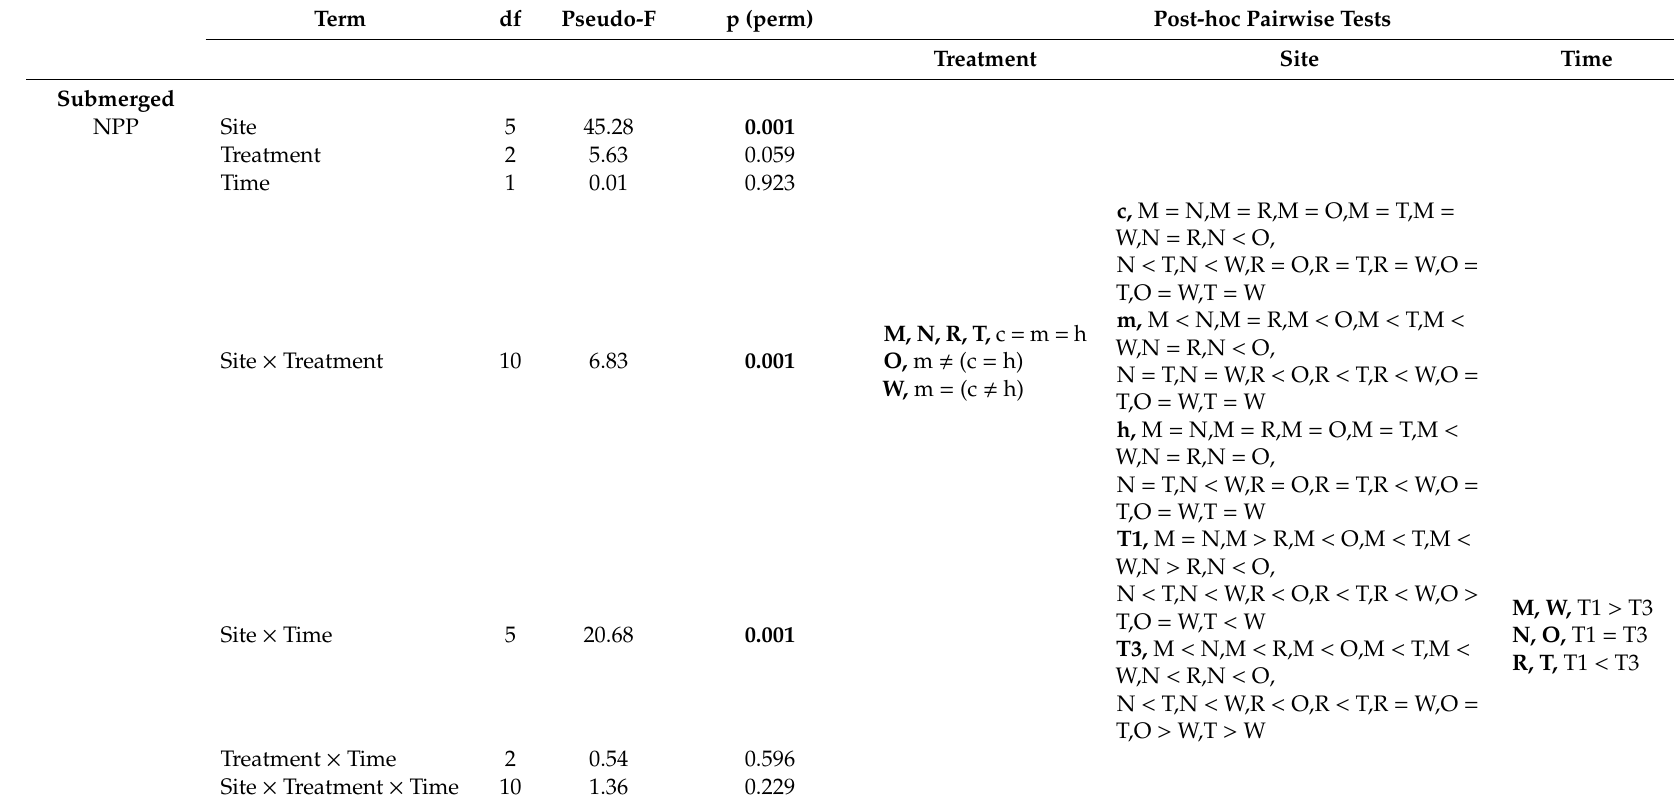
Table A5. A repeated measures PERMANOVA using Euclidean distance was used to detect treatment e ff ects on submerged and emerged primary production estimates. The analysis had treatment (3 levels), site (6 levels) and time (2 levels; sub T1 and T3; em T2 and T3) as fixed factors and replicate plot nested within treatment. Significant e ff ects ( p < 0.05) are given in bold. Main e ff ects were not considered if interaction e ff ects were significant and post hoc pairwise tests were undertaken to identify where di ff erences occurred. For interaction terms Monte-Carlo P-values were used owing to the small number of possible permutations. Site names have been further abbreviated to: M = MNK-L, N = MNK-R, R = RAG, O = TAU-O, T = TAU-T, W = WTA, and control, medium and high nutrient enrichment to c, m and h,